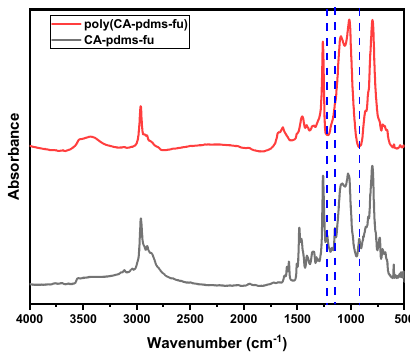
Figure 4. FTIR spectra of CA-pdms-fu and poly(CA-pdms-fu).